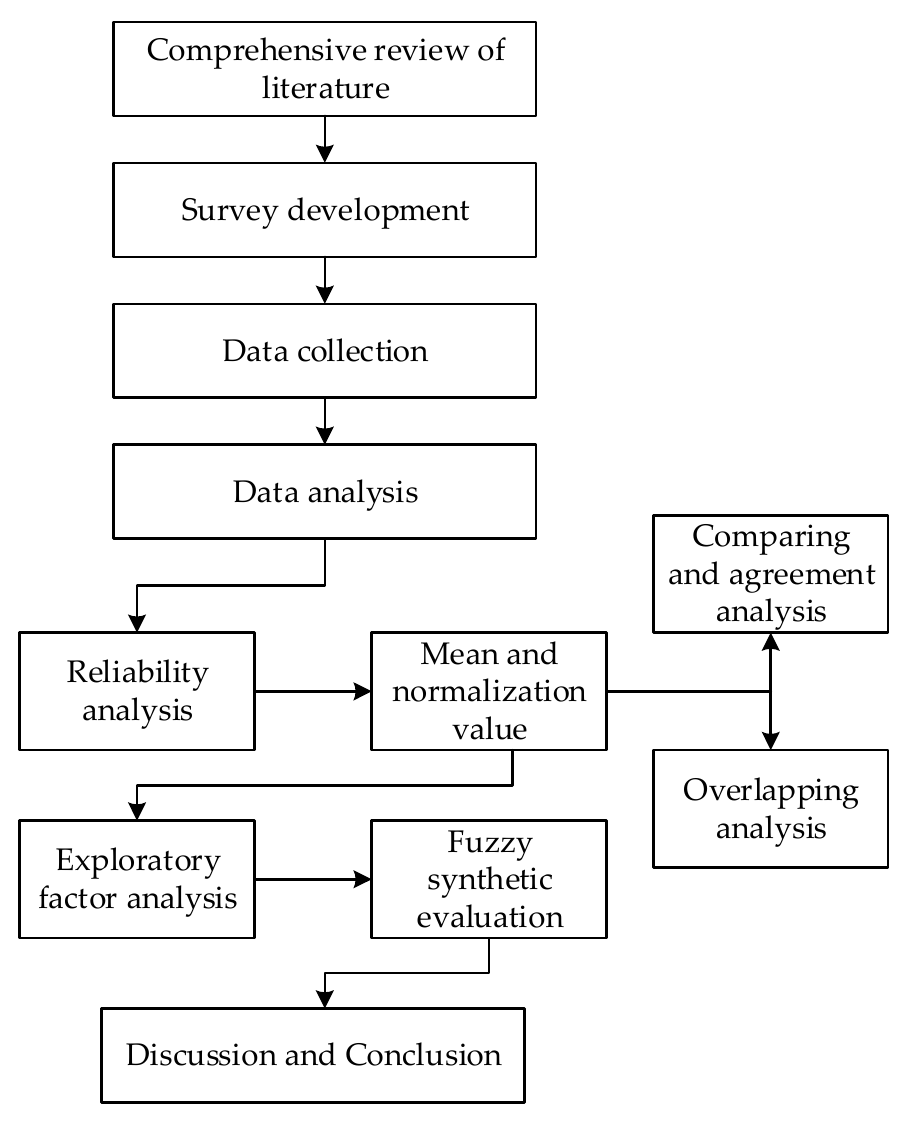
Figure 1. The adopted research workflow.